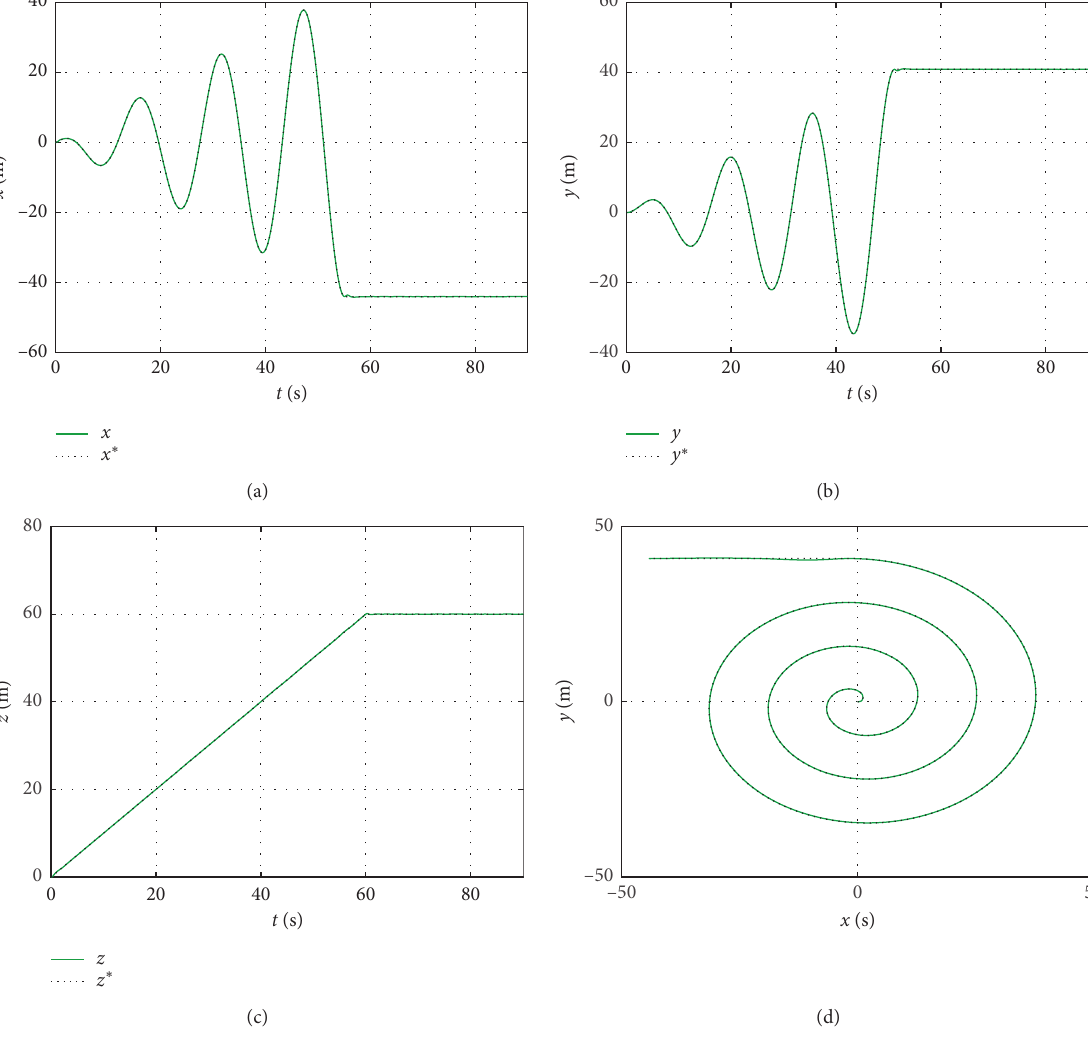
Figure 16: Tracking of the planned motion reference trajectories. (a) Trajectory tracking in X , case 3 (b) Trajectory tracking in Y , case 3 (c) Trajectory tracking in Z , case 3 (d) Path following, case